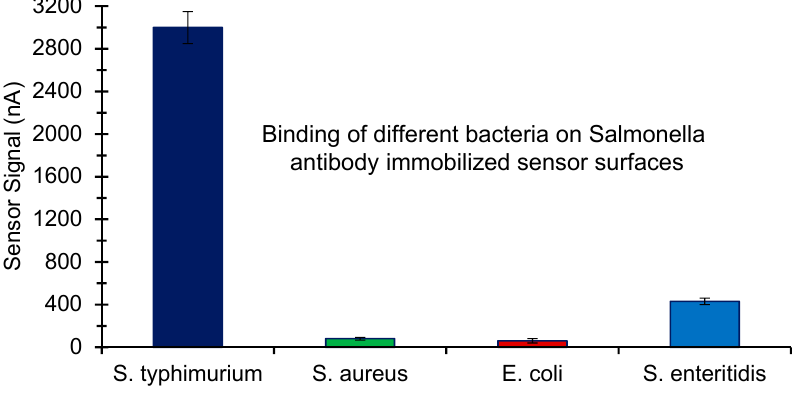
Figure 7. Cross-reactivity tests for S. typhimurium specific antibody sensor assay (n = 3).